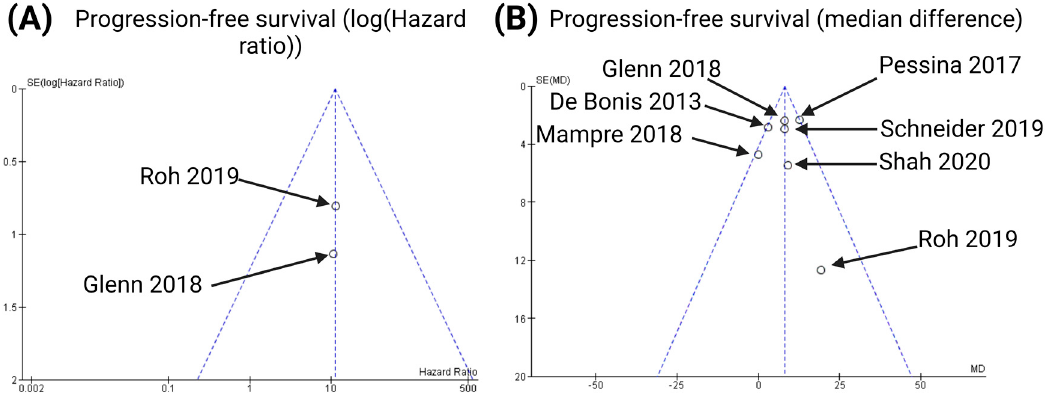
Figure 7. Funnel plots for the following endpoints of the present meta-analysis [24–30]: probability of progression-free survival according to the multivariate Cox regression analyses ( A ) and probability of progression-free survival according to the mean differences of the median progression-free survival times ( B ).